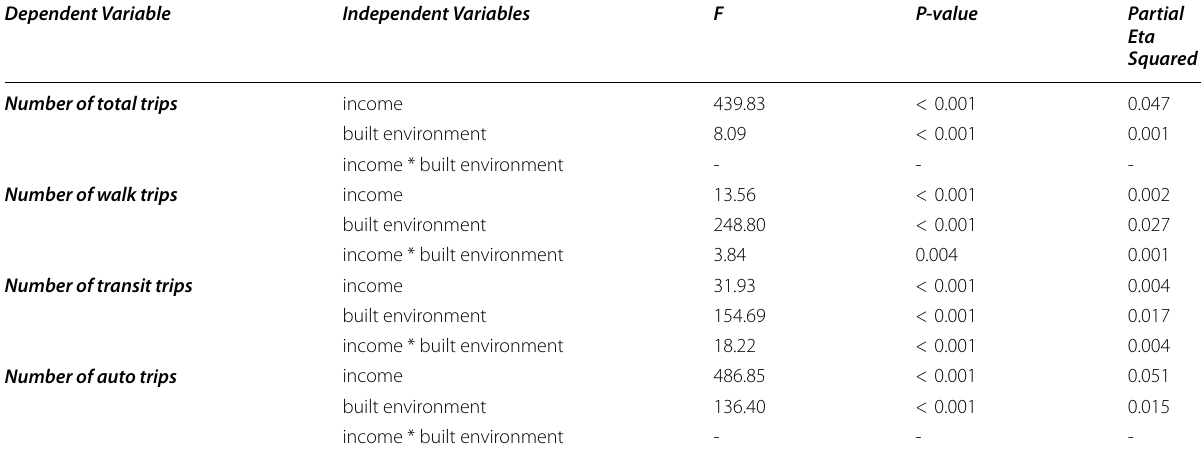
Table 5 Results of two-way ANOVA for the effects of income and built environment on older adults’ travel behavior